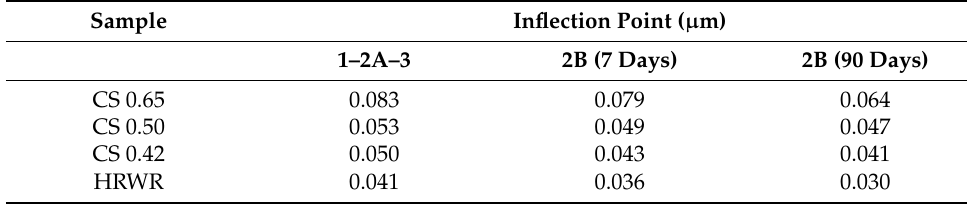
Table 3. Microstructural features of the investigated mortars derived from MIP.